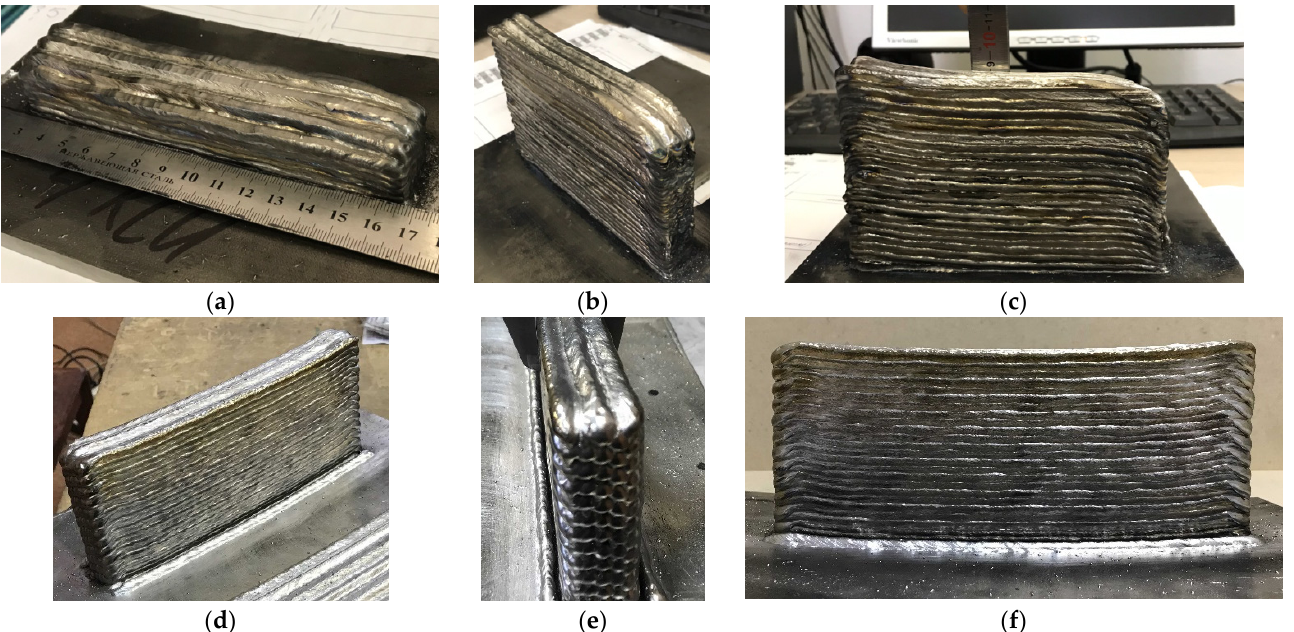
Figure 3. Specimens obtained by multilayer deposition: ( a ) an example of a deposited specimen for cutting horizontal specimens for mechanical tests; ( b – f ) an example of a deposited specimen for cutting vertical and horizontal specimens for mechanical tests.